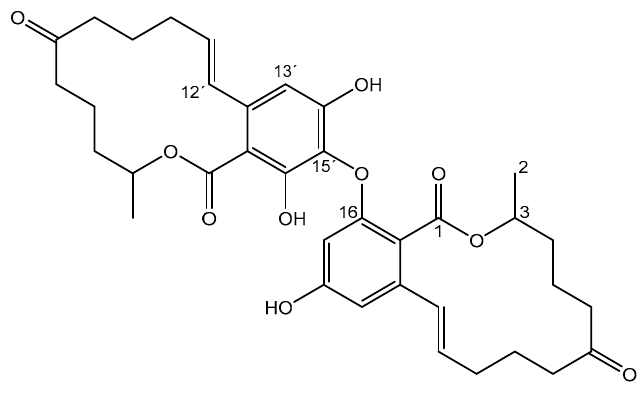
Figure 1. Structure of compound 1.